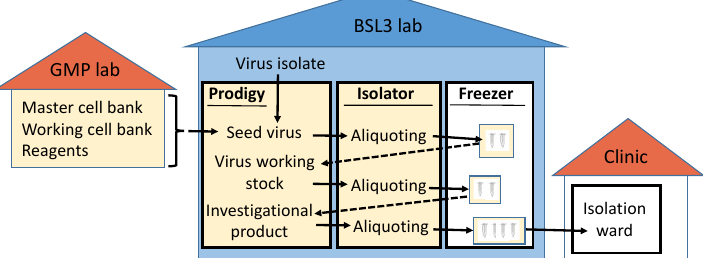
Figure 5. Concept for production of live-attenuated vaccines of SARS-CoV-2 under biosafety level 3 conditions. GMP-compatible working steps are shown in yellow boxes; BSL-3-containment is indicated by the blue background.